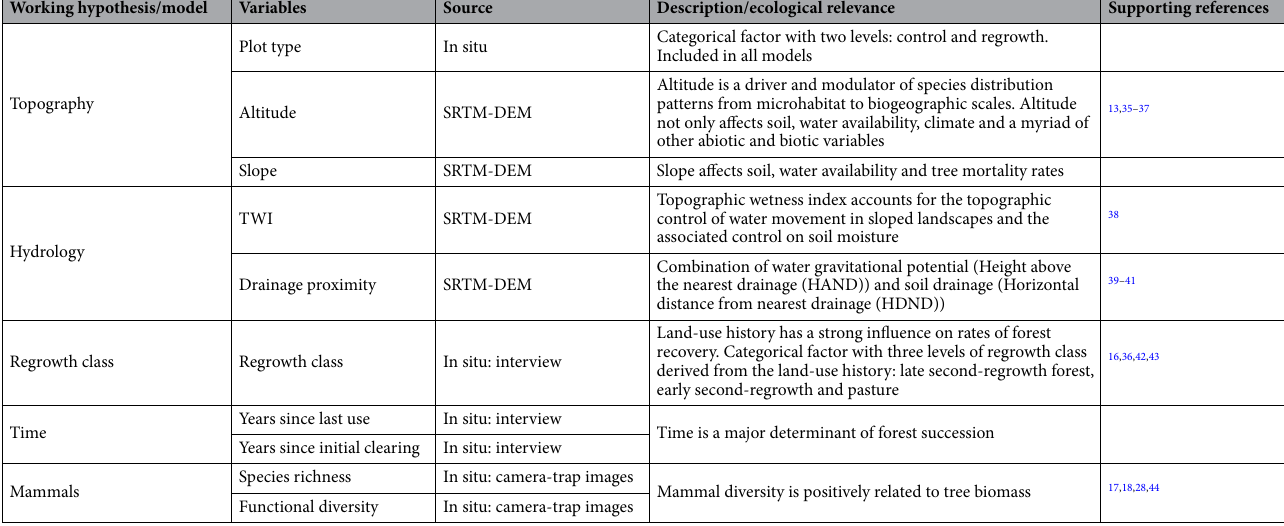
Table 1. Explanatory variables.